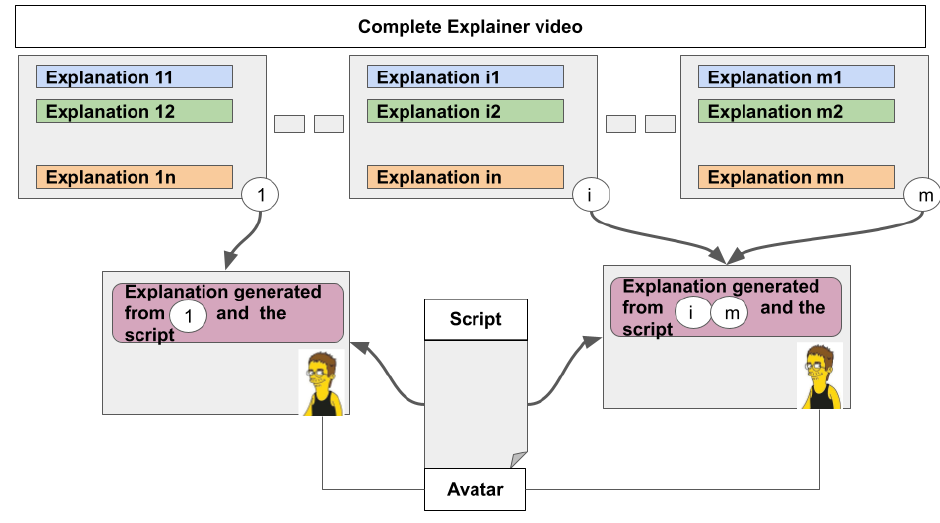
Figure 8. Storytelling